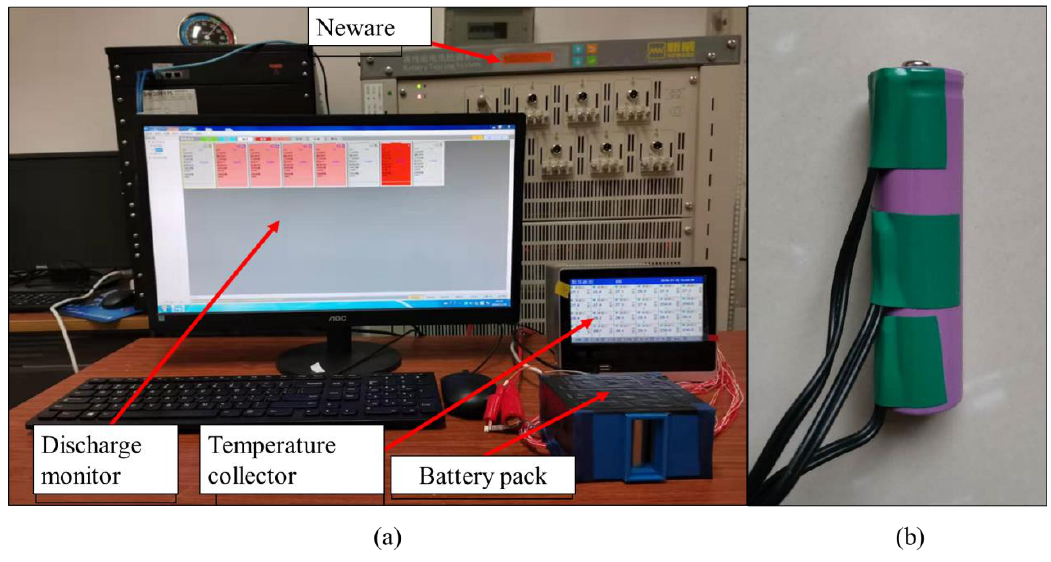
Figure 3. ( a ) Experimental equipment. ( b ) The battery with temperature